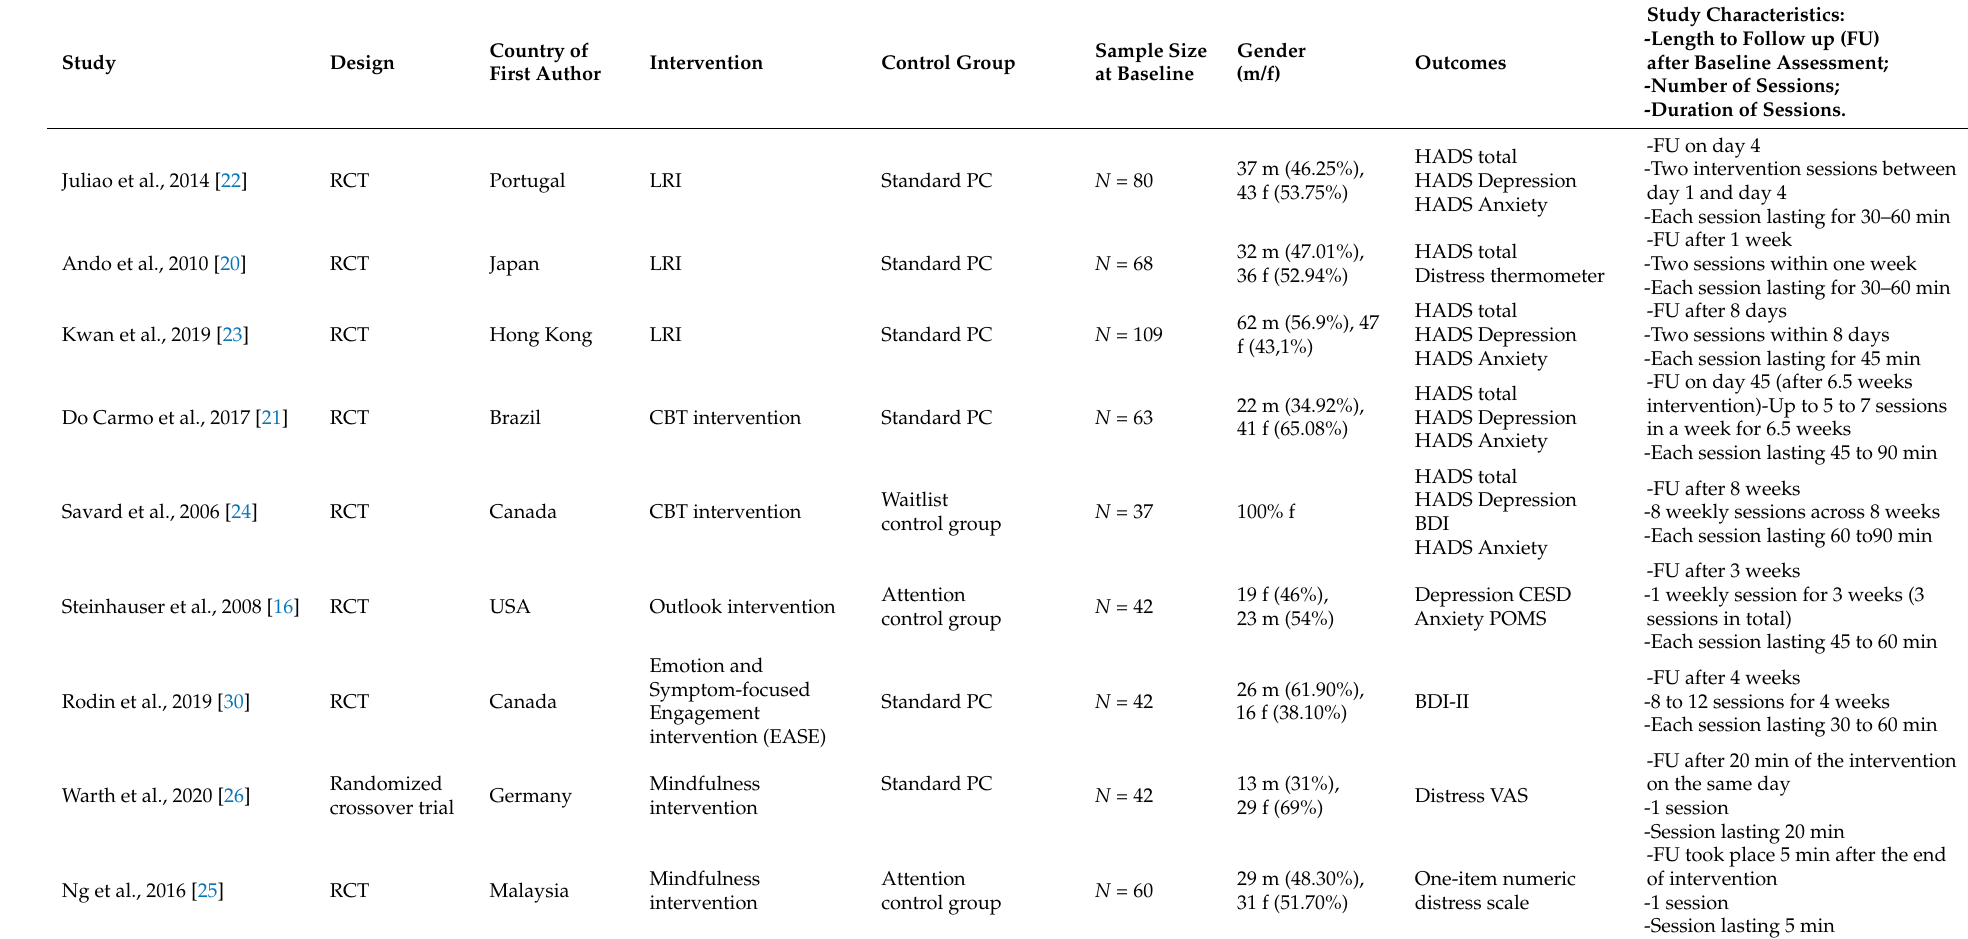
Table 2. Overview of included